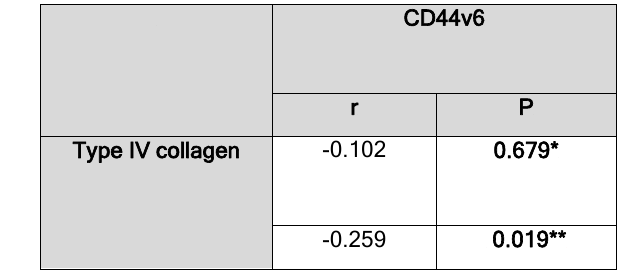
Table 6 Correlation between IHC expression of CD 44v6 and IHC expression of Type IV collagen in borderline and malignant ovarian